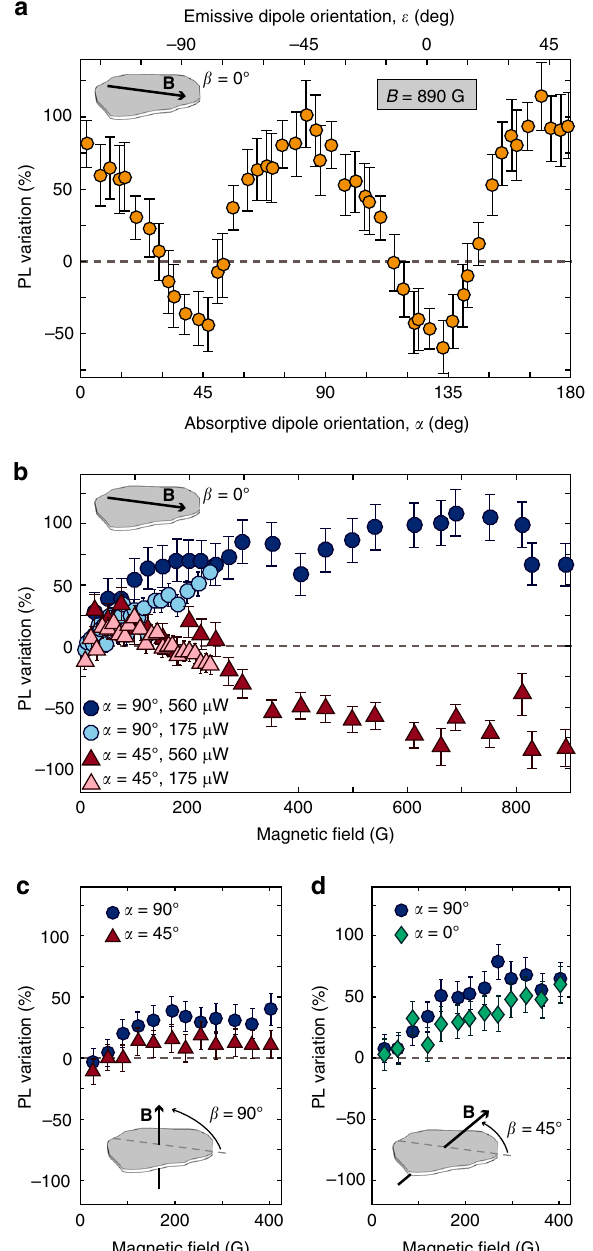
Fig. 2 Anisotropic magnetic- fi eld-dependent PL. a PL variation as a function of the relative orientation between the emitter ’ s optical dipoles and an in- plane B = 890 G. b – d PL variation for magnetic fi elds parallel ( b , β = 0°), perpendicular ( c , β = 90°), and at 45° ( d , β = 45°) to the sample plane. All